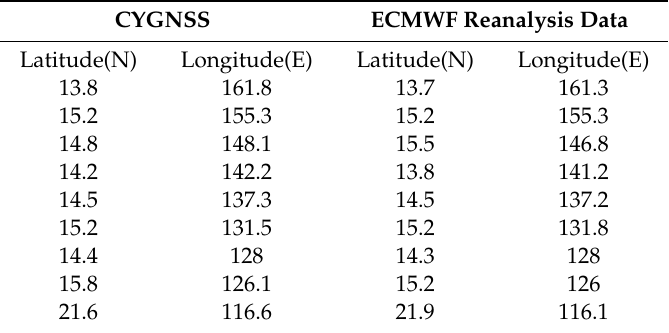
Table 2. Latitude and longitude of maximum wind speed obtained from CYGNSS and ECMWF reanalysis data.